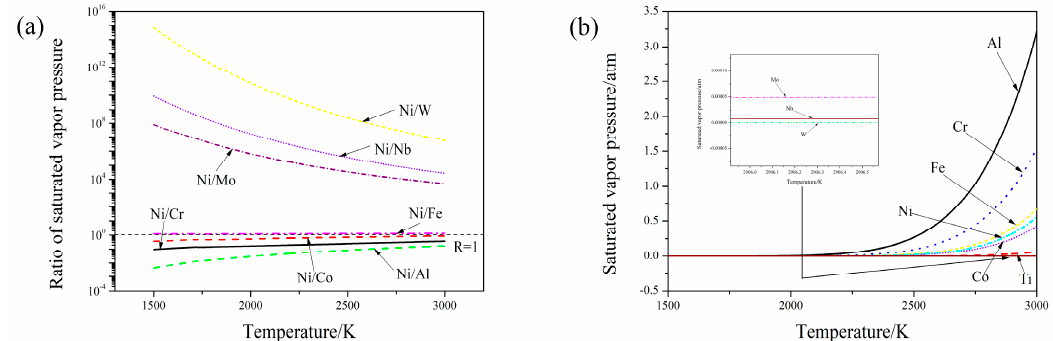
Figure 7. Calculation of saturated vapor pressure among different elements. ( a ) Ratio of saturated vapor pressure. ( b ) Saturated vapor pressure.